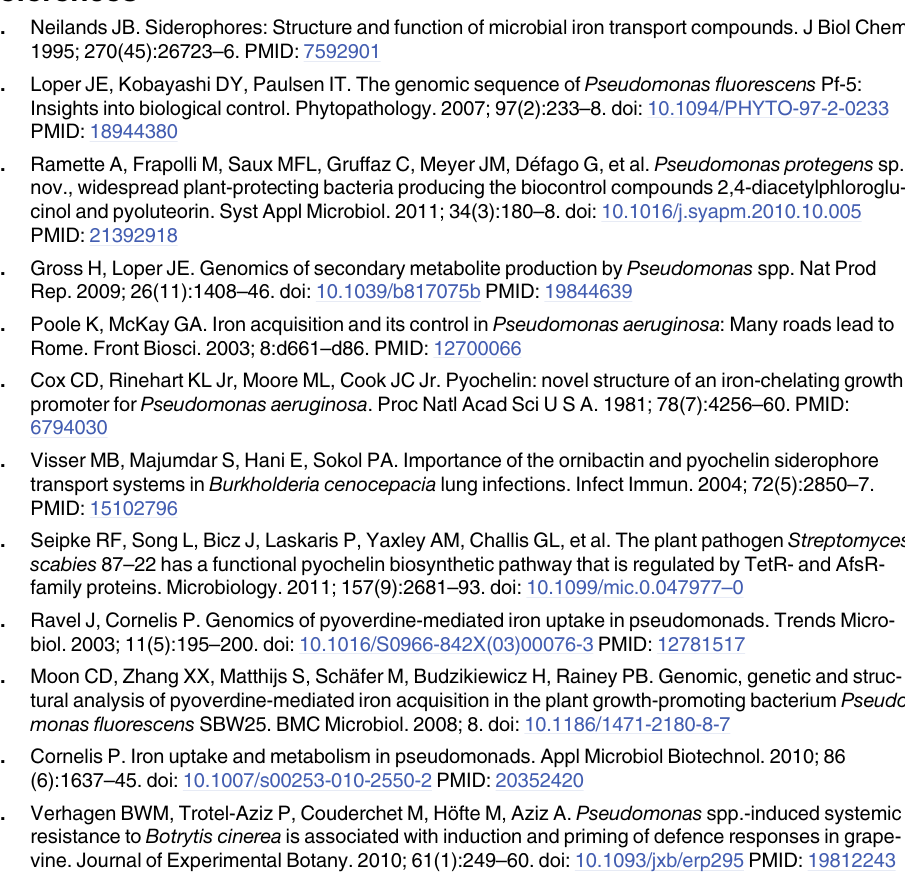
S5 Table. Tests in Phenotypes microarray that showed differential respiratory kinetics between wild-type and mutant